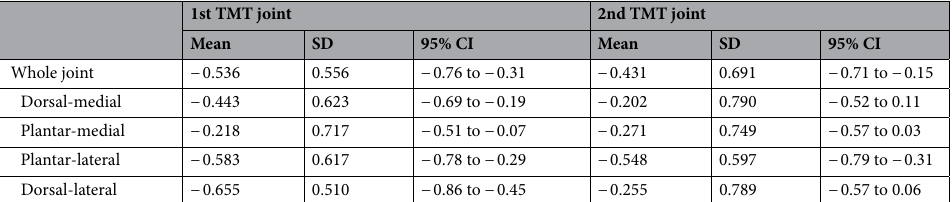
Table 4. Curvature similarity values for the whole joint and four quadrant subregions of the first and second TMT joints. Positive values show matched curvature, with one concave and one convex surface. Negative values show mismatched curvature, with either two concave or two convex surfaces. Magnitudes greater to one show more similar curvature magnitudes between opposing surfaces.